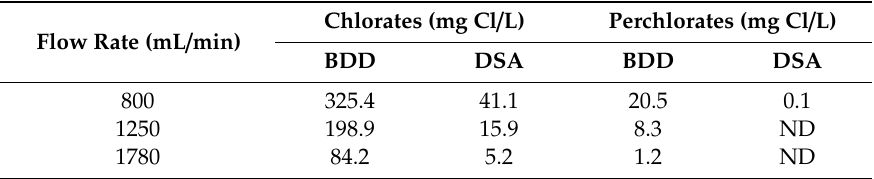
Table 2. E ff ect of the flow rate on the concentrations of chlorates and perchlorates formed during the electrolytic treatment of synthetic urine at pH 5.5 using BDD and DSA anodes and a stainless steel cathode at 20 mA / cm 2 after the consumption of 17 Ah /